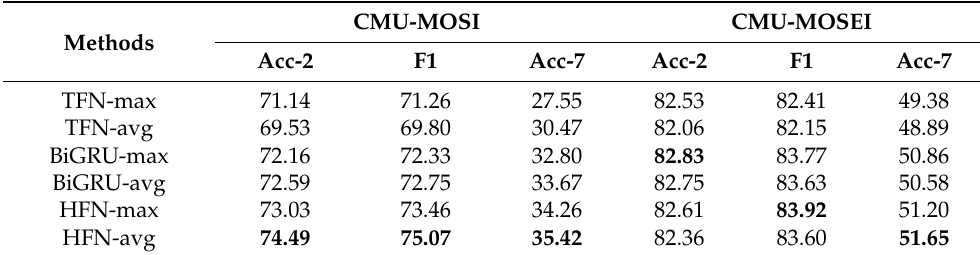
Table 5. Performance comparison over CMU-MOSI and